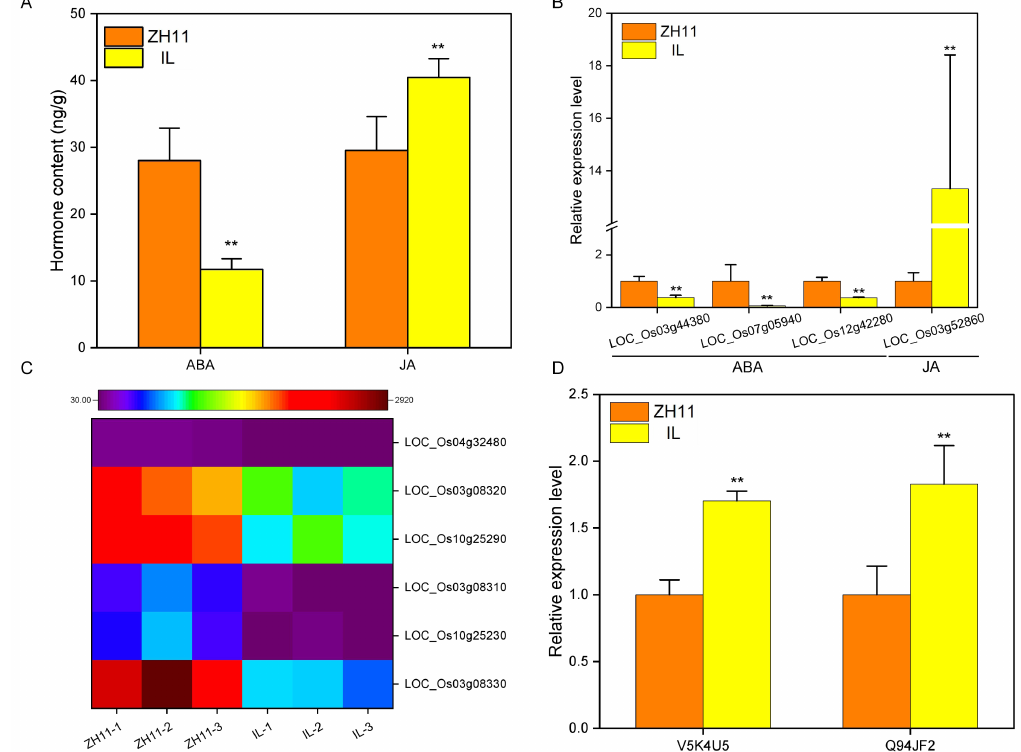
Figure 5. Analysis of hormone content and signal transduction pathways. ( A ) Contents of abscisic acid and jasmonic acid in the seeds of IL and ZH11 following six hours of imbibition. ( B ) Relative expression of abscisic acid and jasmonic acid synthesis genes in the seeds of IL and ZH11 following six hours of imbibition. ( C ) DEGs of signal transduction genes of jasmonic acid in IL and ZH11. ( D ) DEPs of signal transduction proteins of abscisic acid in IL and ZH11. The data represent the mean ± SD ( n = 3), ** p ≤ 0.01.